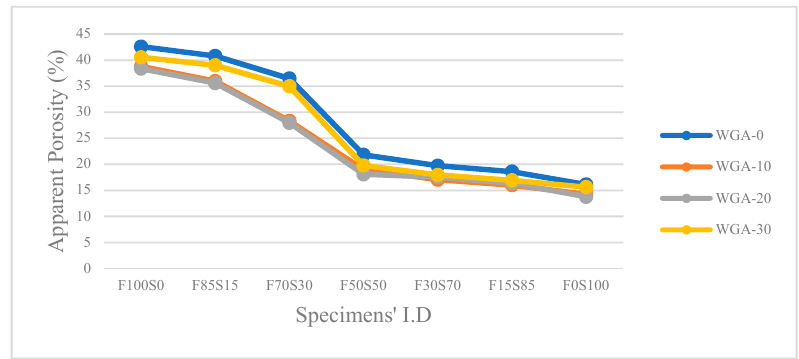
Figure 6. Apparent porosity of WGA-activated FA/GGBS samples.